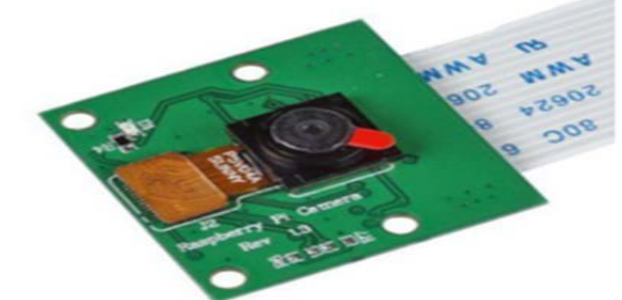
Figure 6. Raspberry Pi 5MP